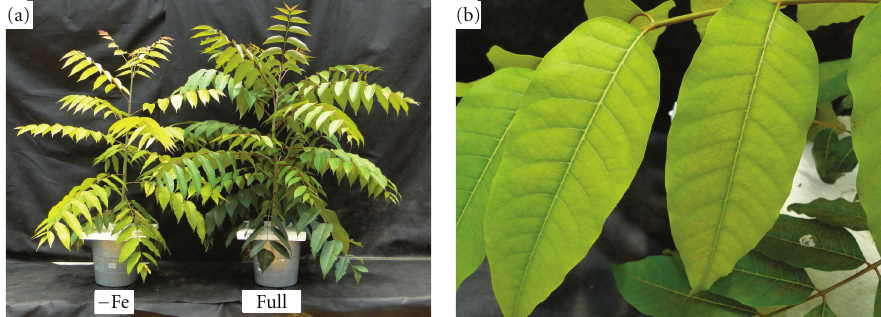
Figure 7: Symptoms of Fe deficiency on Australian Red Cedar seedlings. Chlorosis, smaller size and number of leaves in the treatment with Fe omission in relation to the full treatment (a) fine reticulate on the leaflets (b).